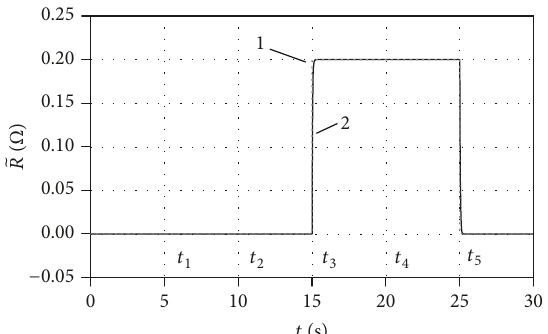
Figure 3: Estimation of variable fault system.